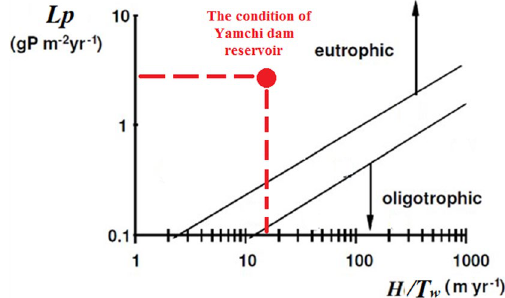
Fig. 12 The status of the Yamchi dam reservoir in the modified Vol- lenweider